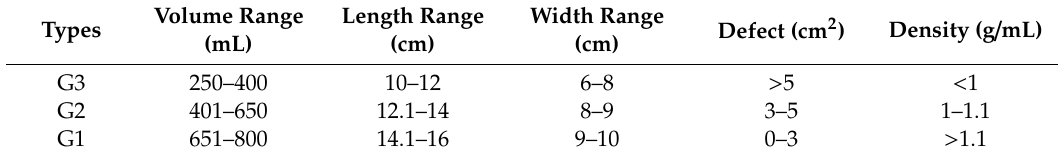
Table 1. Standard type